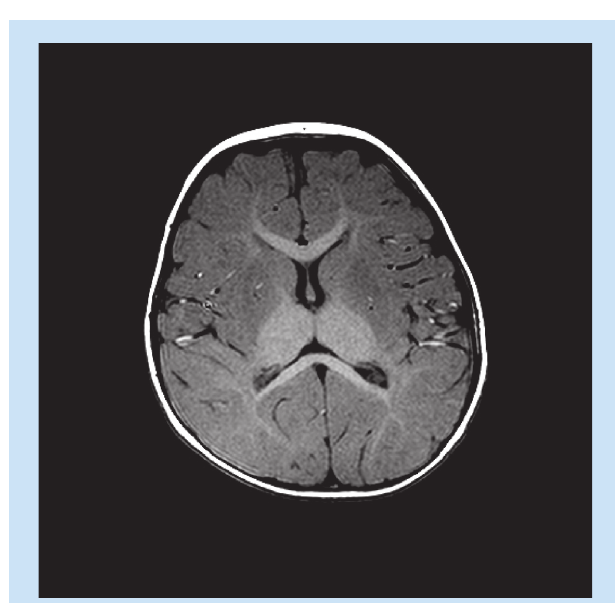
Fig. 2. Axial T1WI at the thalamic level demonstrating diffuse thalamic